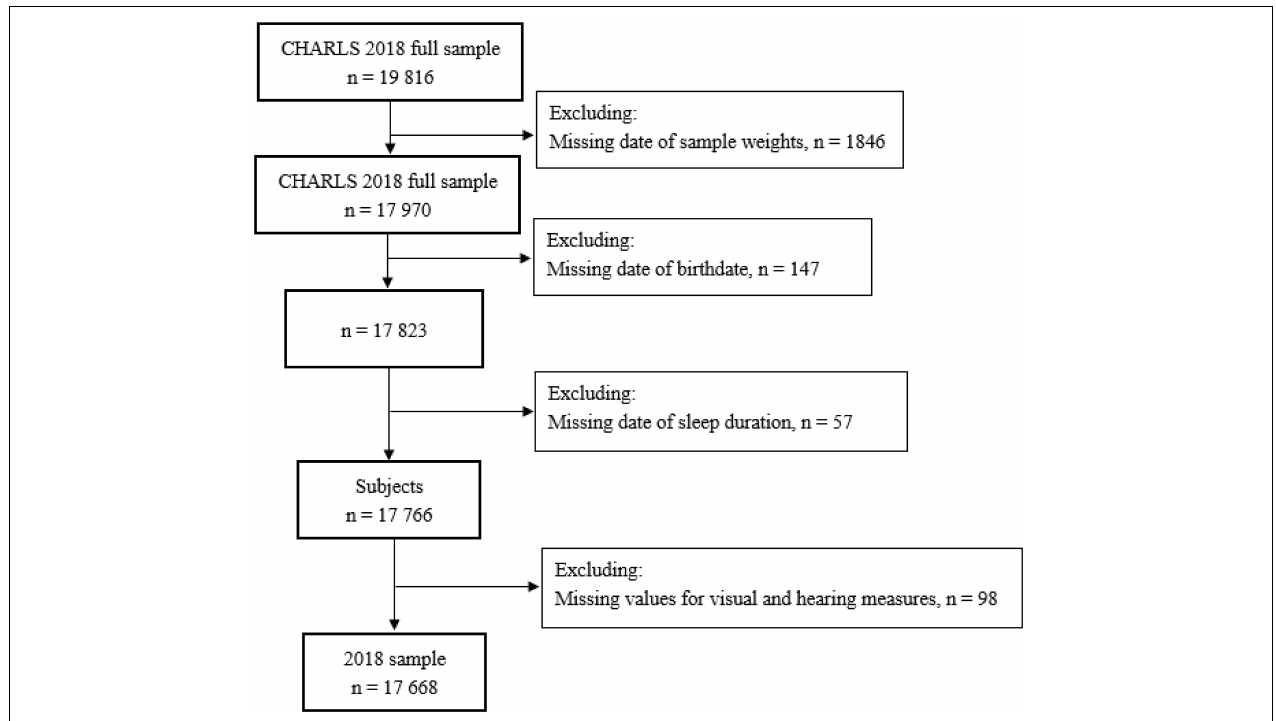
FIGURE 1 | Flowchart of the study sample from the 2018 China Health and Retirement Longitudinal Study